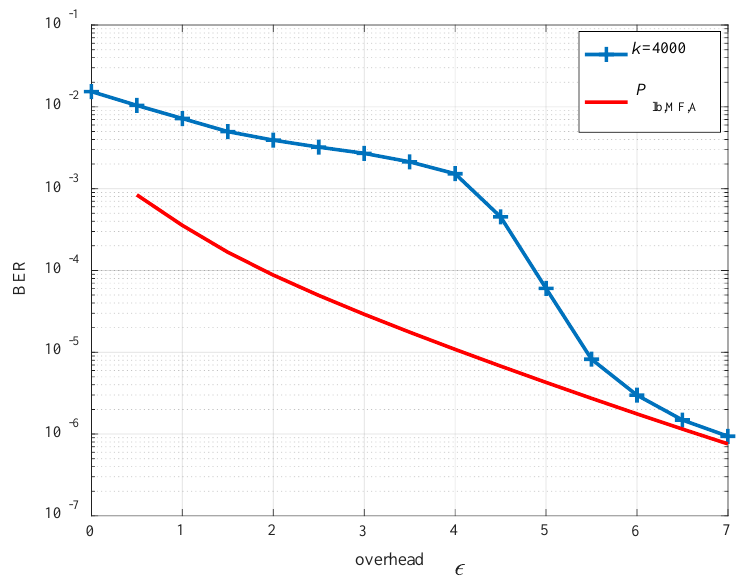
Ω x with =4000 k . Figure 5. BER performance of source node A when using opt ( x ) with k = 4000. opt